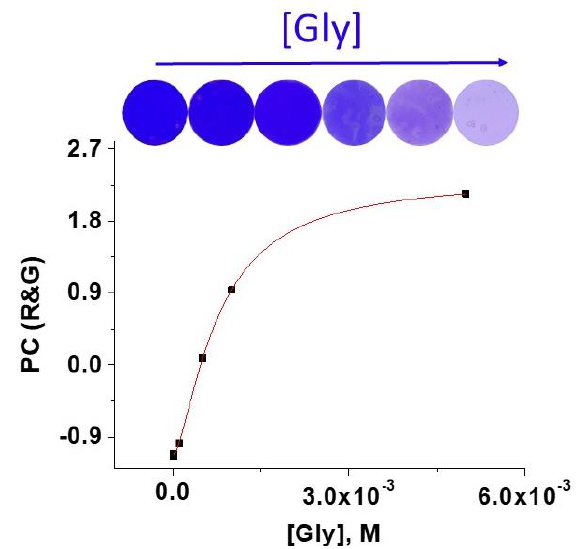
Figure 5. Titration of with Gly with F (3)-Cu-D by RGB method. The top of the figure shows the photographs of F (3)-Cu-D discs after immersion for 60 min in 0.63 mL of MeOH : pH 7 buffer solution (1:1) for concentrations of glycine ranging from 1 × 10 −6 M to 5 × 10 −3 M.